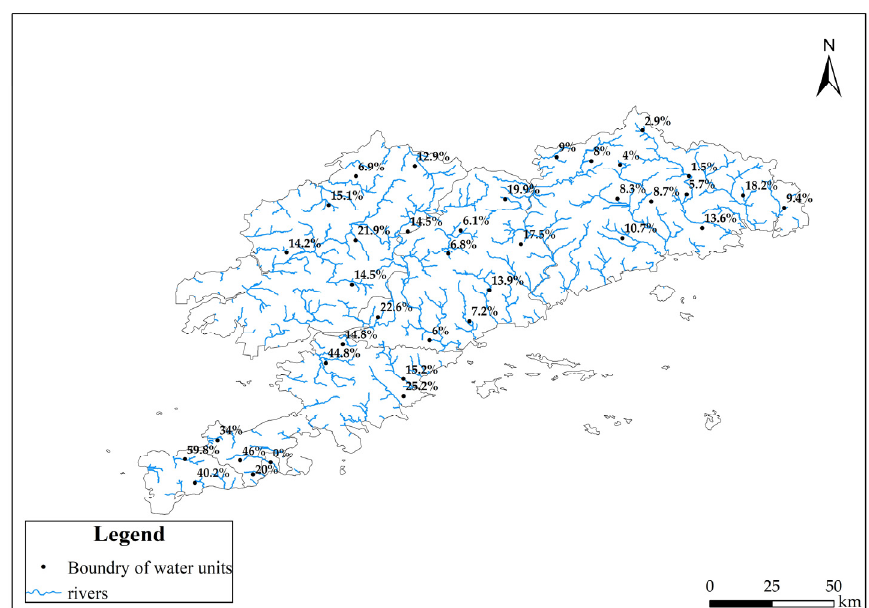
Figure 3. Relationship between regional pollutant emissions and water distribution.